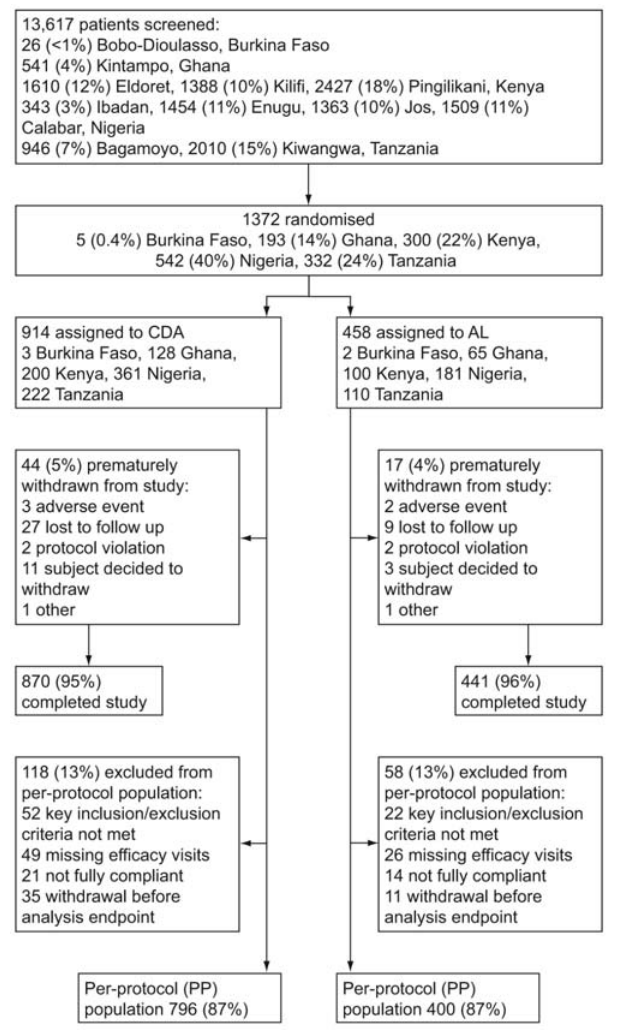
Table 2. G6PD genotype (ITT